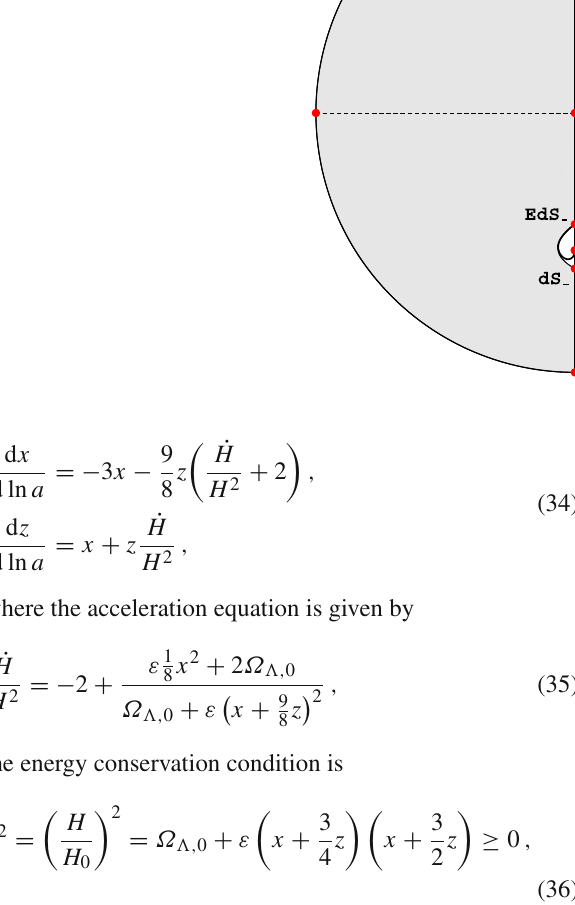
Fig. 3 The phase space diagrams representing evolutional paths of the decoupled part in the ( u , ¯ v) dynamical variables of the system (22) with λ = − 5 for 2 the canonical ε = + 1 (top) and the phantom ε = − 1 (bottom) scalar fields. The shaded regions of the phase space are unphysical where the energy conservation condition (21) is negative. Direction of arrows on the phase space trajectories indicates expansion of the universe. For − 5 > λ > − 1 the Einstein–de Sitter state EdS − is unstable with respect to expansion of the universe while the de Sitter state dS − is in the form of a saddle type critical